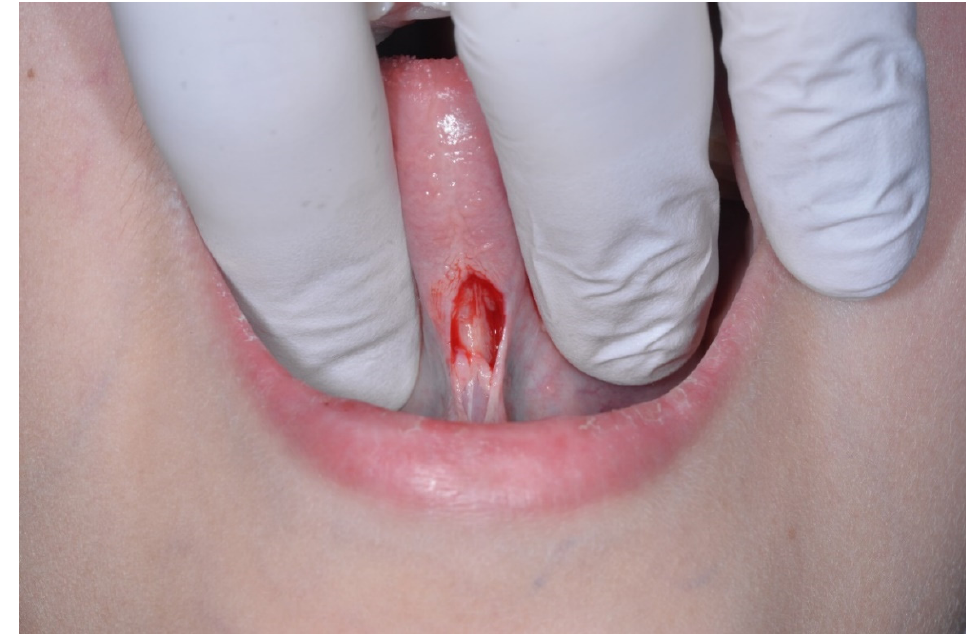
In all the cases the incision left a diamond-shaped pattern in the mucosa that has been Figure 2. Starting the surgery using a 15c blade. Figure 2. Starting the surgery using a 15c blade. extended laterally, to guarantee the movements of the tongue (Figure 3).